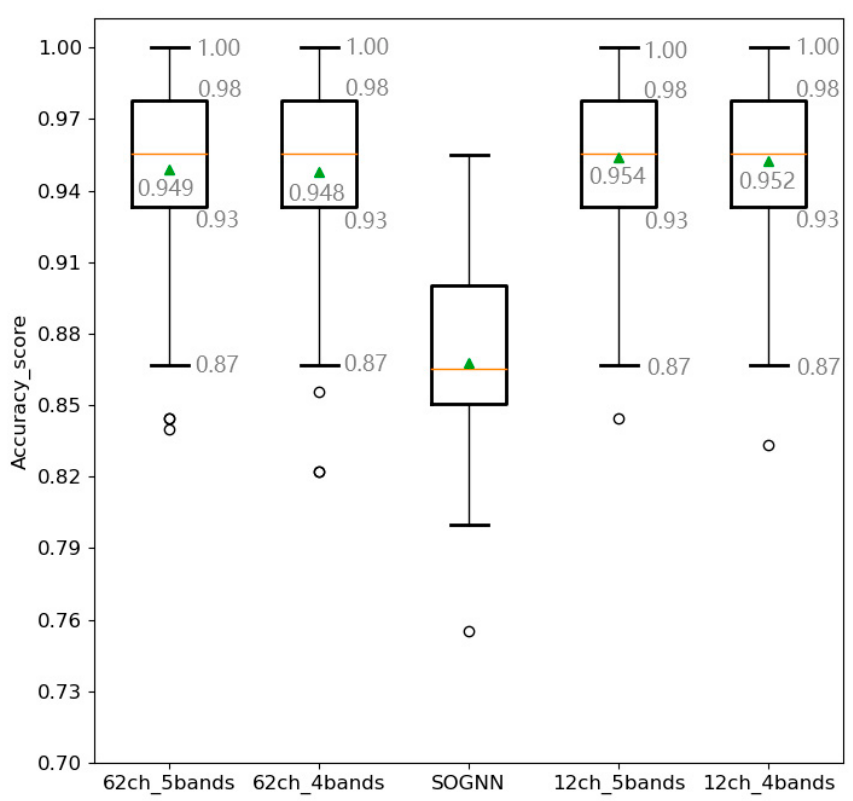
Figure 5. Box plot of multi-band feature fusion of different channels.